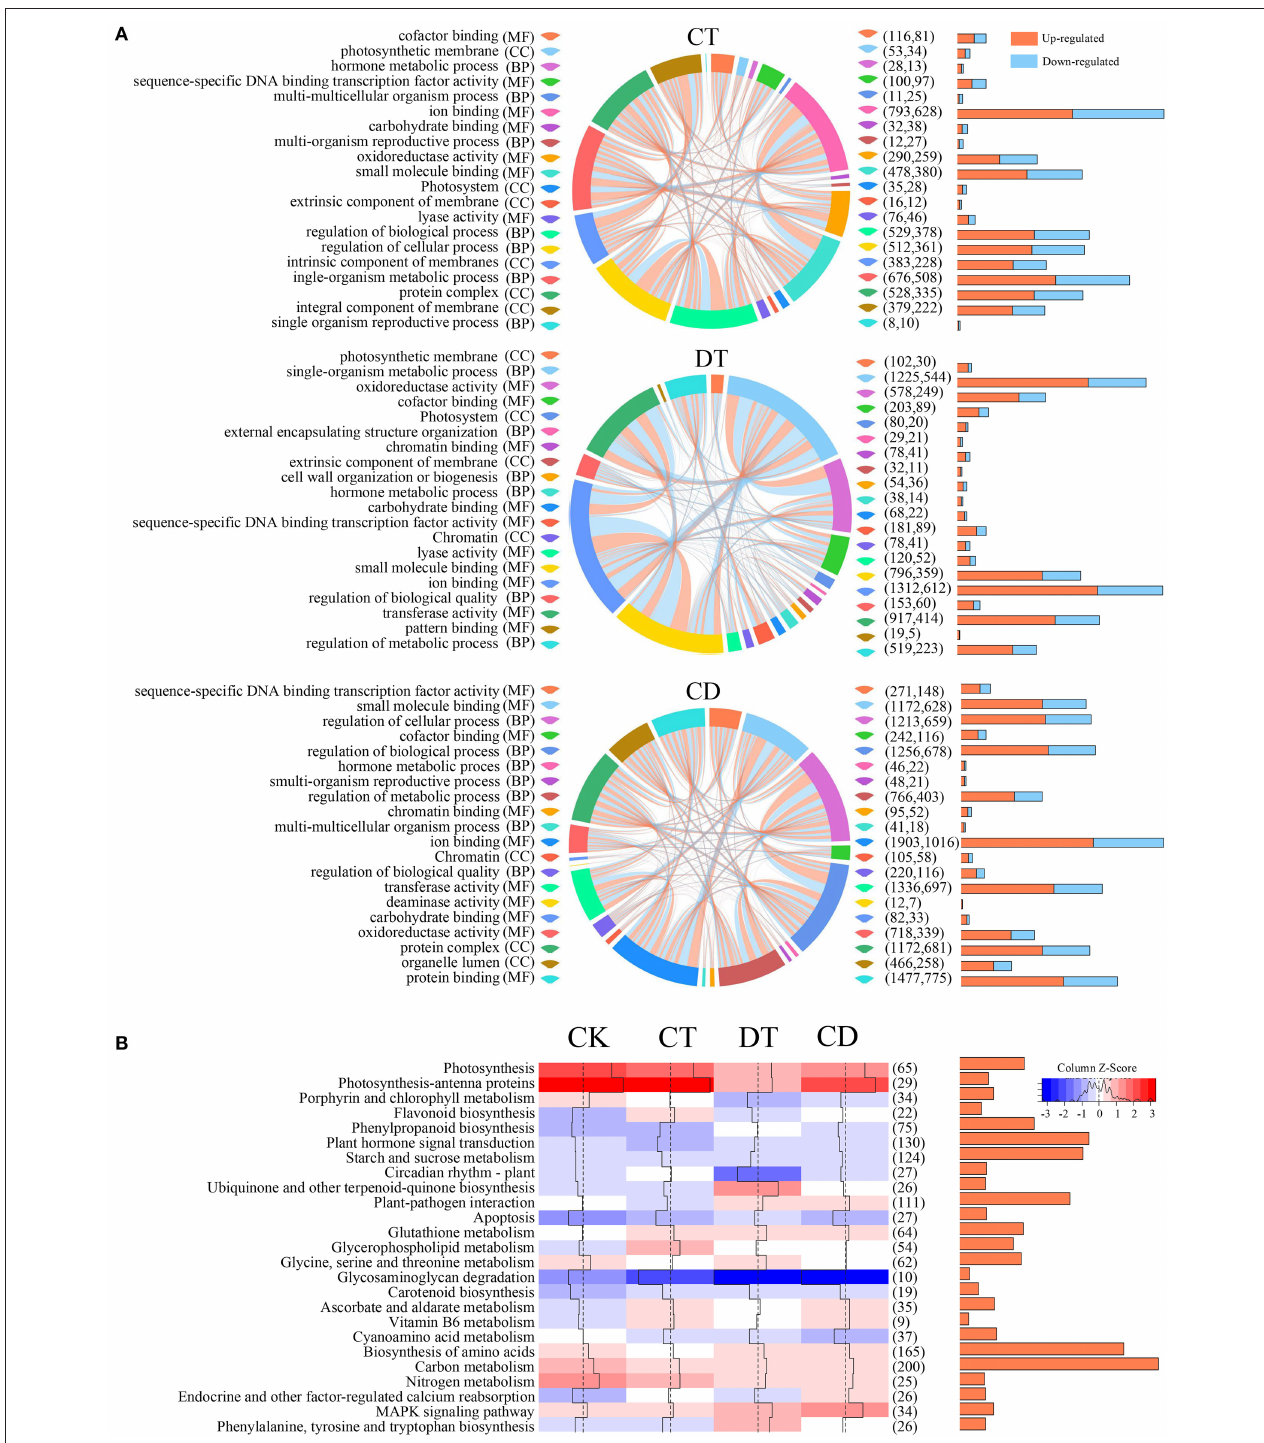
FIGURE 5 | GO and KEGG pathway analysis of DEGs under CT, DT, and CD. (A) Multi-series chord graphs for the top 20 level-3 GO terms of each stress treatment. The size of the segments around the circumference of the circle indicate the number of DEGs in specific GO terms. The orange (up-regulated) or blue (down-regulated) lines within the circle indicate the DEGs involved in different biological processes. The numbers of up- and down-regulated DEGs were shown in the right bar graphs and parentheses. (B) Heat map showing the overall expression levels of 25 enriched pathways during CT, DT, and CD. The color represents the mean expression values of DEGs within the pathways. The total numbers of DEGs in the pathways were shown in the right bar graphs and parentheses.